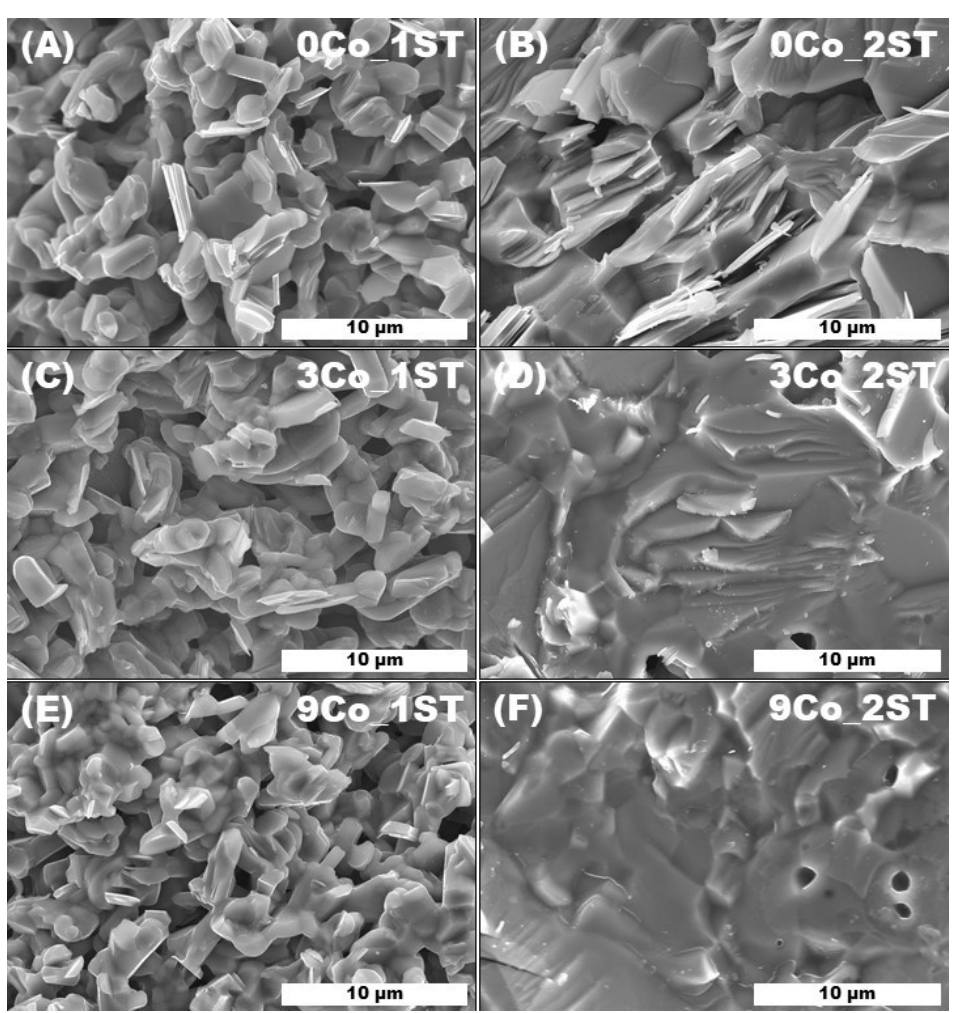
Figure 3. Representative SEM micrographs of fractured 1ST and 2ST sintered samples: ( A ) 0Co_1ST, ( B ) 0Co_2ST, ( C ) 3Co_1ST, ( D ) 3Co_2ST, ( E ) 9Co_1ST and ( F ) 9Co_2ST.